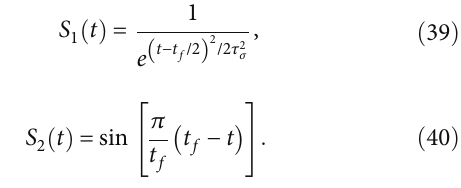
ð t Þ with di ff erent values of w and t 3